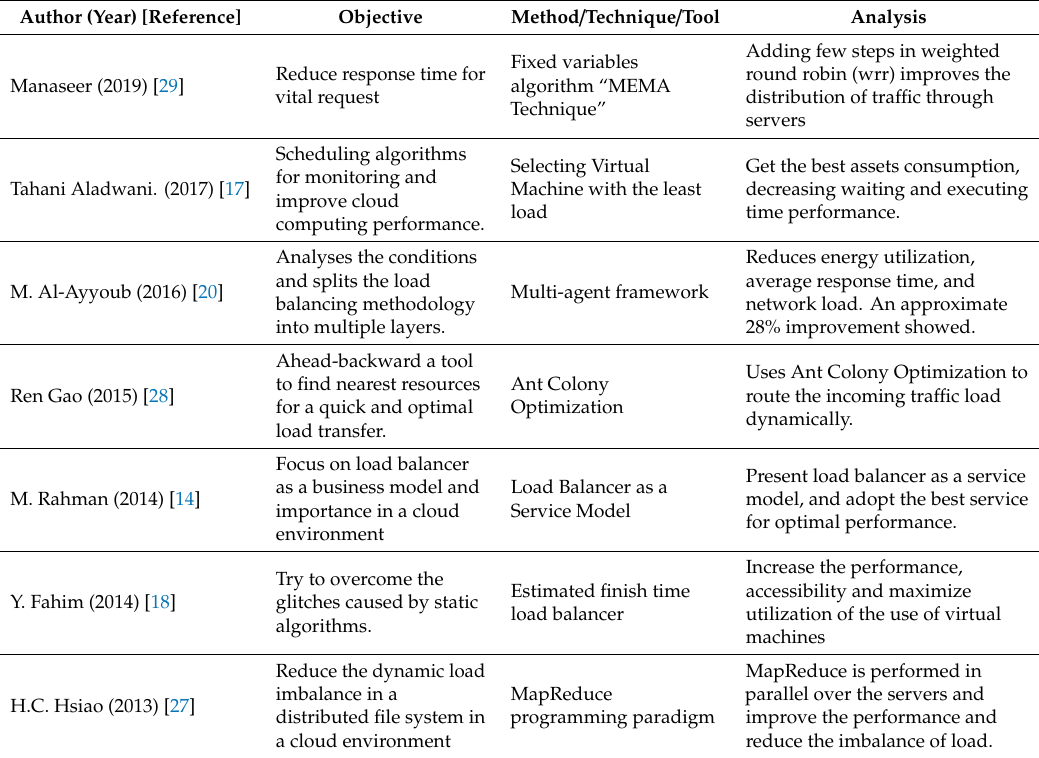
Table 2. Comparison of Related